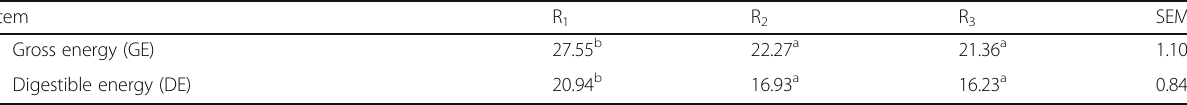
Table 4 Productive performance of the experimental groups (Continued) Item Gross energy (GE)